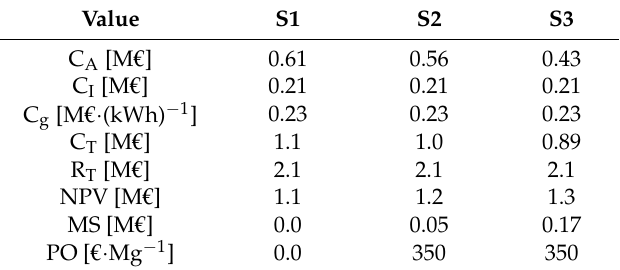
Table 2. Economic assessment overview